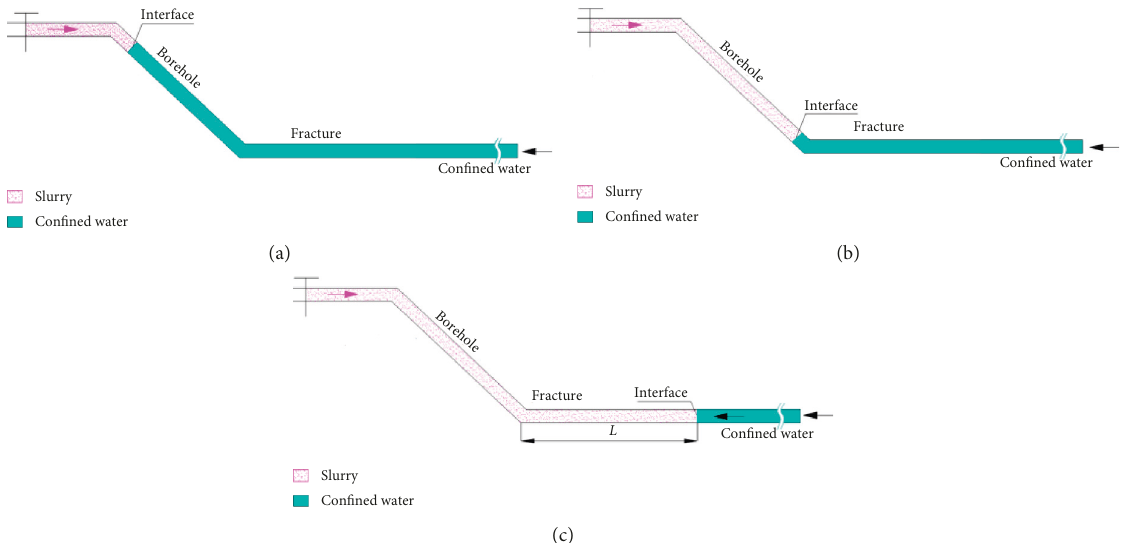
Figure 2: Different stages of the grouting process. (a) Initial grouting. (b) Slurry diffusion. (c) Final grouting. L is the penetration distance.